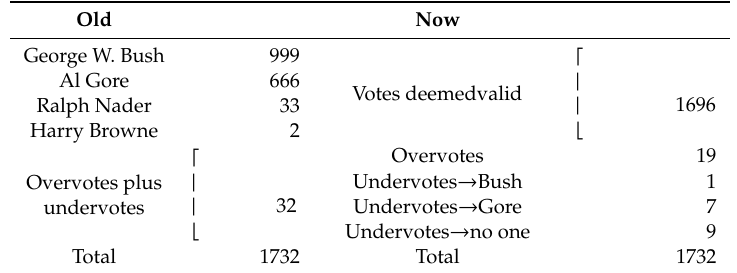
Table 4. Vote tallies for the Panther Parkway precinct (2000 election, Scenario